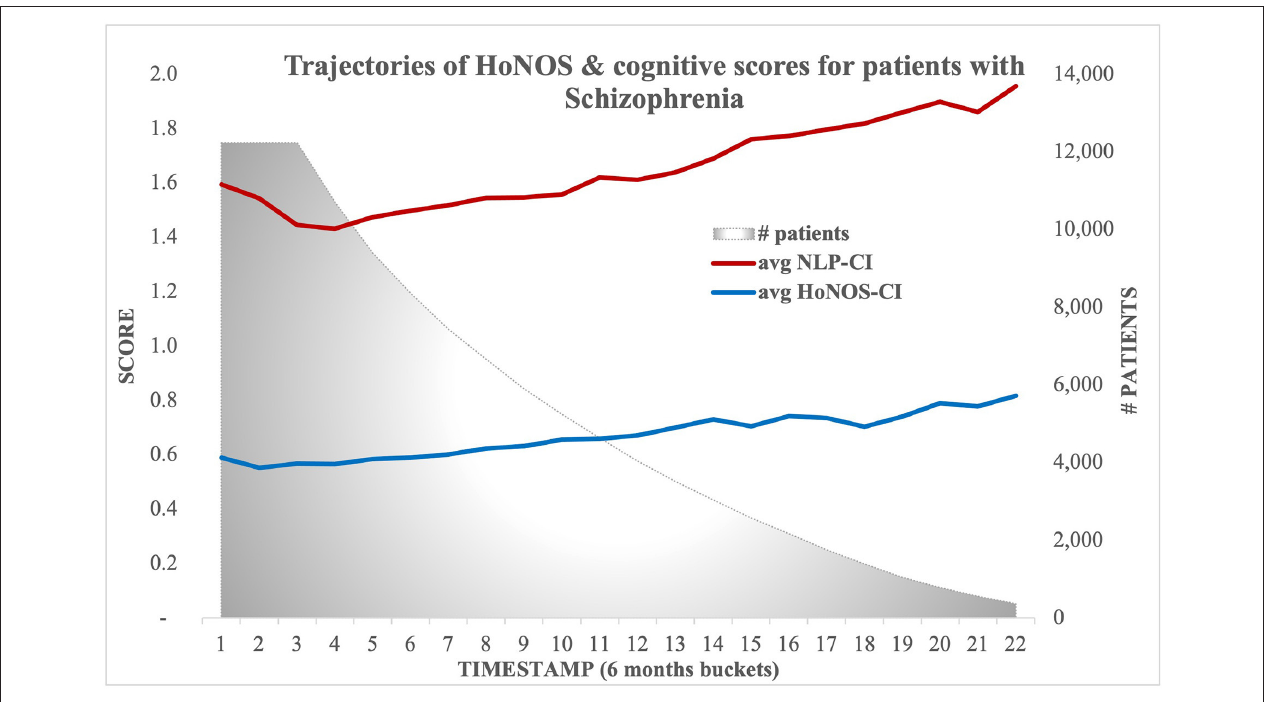
FIGURE 3 | Trajectories of HoNOS and NLP-based Cognitive Impairment scores (Sample